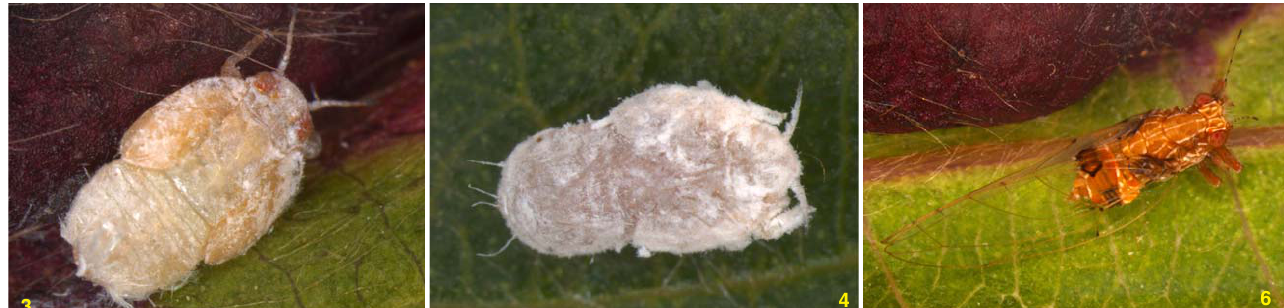
Image 5. Nymphs and honey dew globules inside the